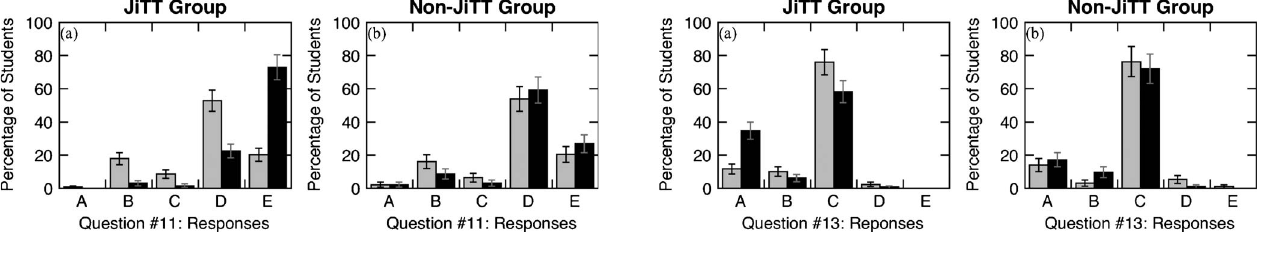
FIG. 4. Student responses to FCI question no. 11 on the pretest (cid:1) gray (cid:2) and post-test (cid:1) black (cid:2) . The correct response is E and the pri- mary distractors are B and D. (cid:1) a (cid:2) JiTT and (cid:1) b (cid:2) Non-JiTT.